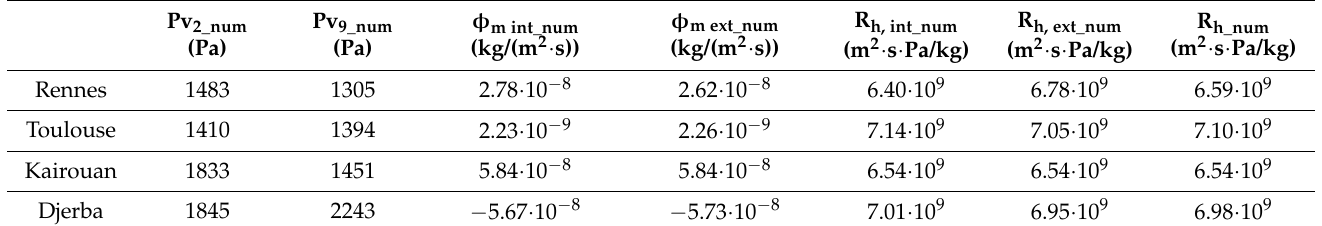
Table 8. Numerical moisture fluxes and R h values after 300 days of